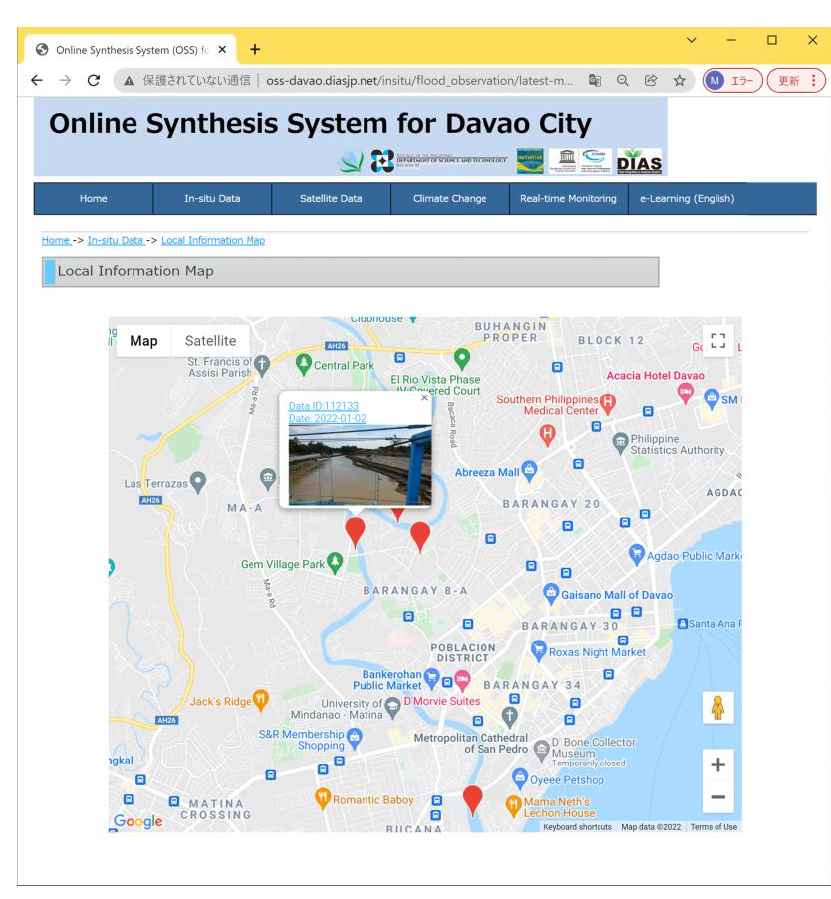
Figure 6. Example window of local information map in the OSS-SR for Davao City.